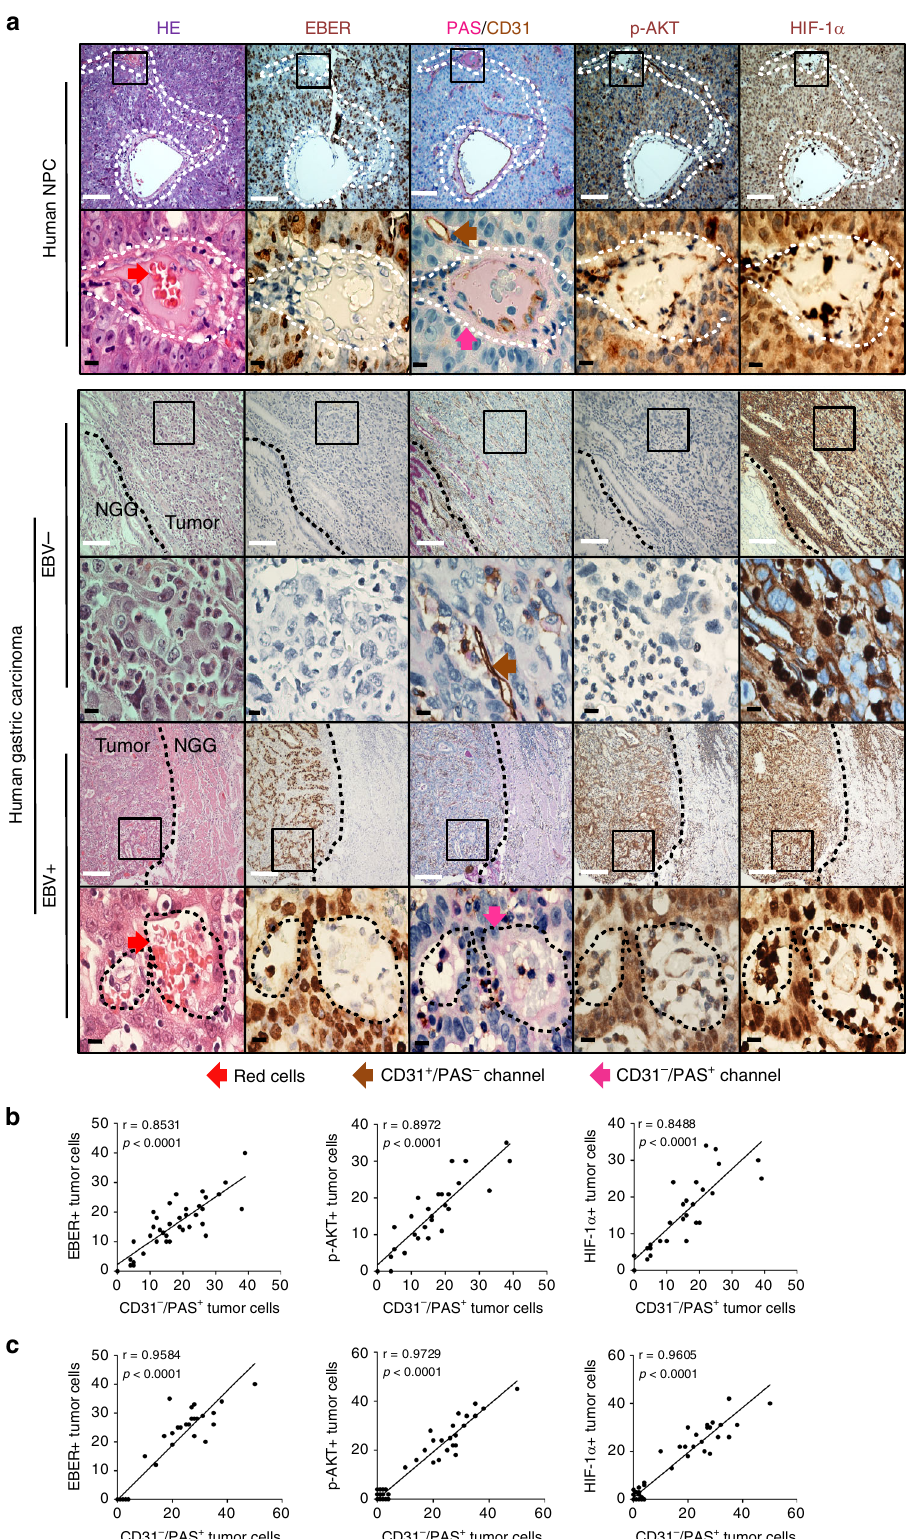
Fig. 7 Correlation of VM with EBV infection in NPC and EBVaGC. a (top) NPC and (bottom) EBV-negative and EBV-positive gastric carcinoma serial sections were stained with H&E, EBER, PAS, and antibodies targeting human CD31, p-AKT, and HIF-1 α . White scale bars = 100 μ m, black scale bars = 10 μ m. b Pearson correlation of PAS + /CD31 − tumor cells of VM with EBER, phosphorylated AKT or nuclear HIF-1 α staining in NPC tissue. p < 0.001, r = regression coef fi cient. c Pearson correlation of PAS + /CD31 − tumor cells with the staining as in b in EBV − and EBV + human gastric carcinoma samples, p <